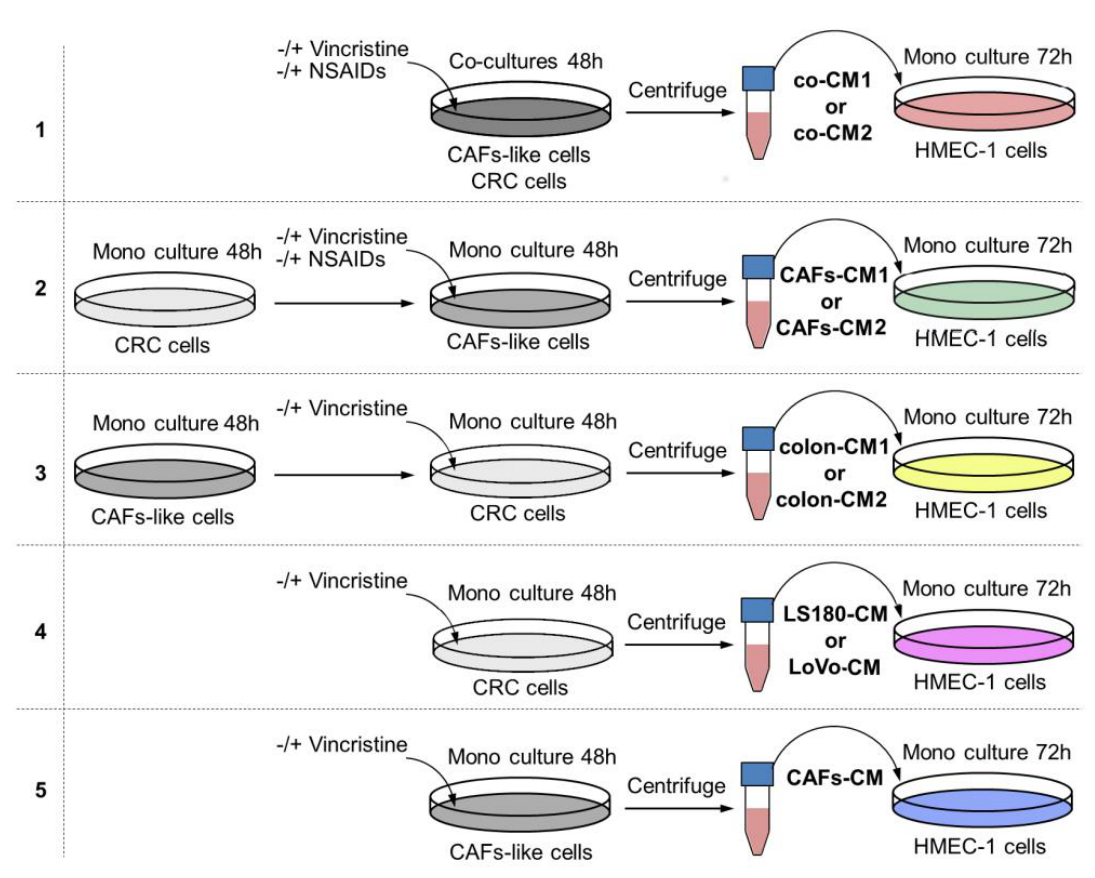
Figure 1. The research scheme for determining the role of NSAIDs in preventing vincristine-dependent CAF formation. In each experiment, the conditioned medium (CM) obtained from preinvasive colon cancer cells (LS180) was called CM1, and from invasive cell line LoVo, CM2. Each CM was labeled with other colors according to the scheme. Model 1 . The coculture of colon cancer cell lines and CAF-like cells were maintained during 48 h and, if necessary, treated with vincristine (VIN) during the final 24 h. The CM was collected, centrifuged, and added to HMEC-1 cells grown in MCDB-131 medium in a 1:3 ratio for 72 h. In some experiments, NSAIDs (AsA or IBU) were added to the coculture cells for the final 24 h. Model 2 . The colon cancer cell lines were maintained in DMEM medium for 48 h. Next, CM was collected, centrifuged, and added to CAF-like cells. CAFs were treated, if necessary, with vincristine (VIN) during the final 24 h. Then, CM was collected, centrifuged, and finally added to HMEC-1 cells grown in MCDB-131 medium in a 1:3 ratio for 72 h. In some experiments, NSAIDs (AsA or IBU) were added to the CAF-like cells for the last 24 h. Model 3 . The CAF-like cells were grown for 48 h. Next, CM was collected, centrifuged, and added to colon cancer cell lines. Colon cancer cells were treated, if necessary, with vincristine (VIN) during the final 24 h. Then, CM was collected, centrifuged, and added to HMEC-1 cells grown in MCDB-131 medium in the 1:3 ratio for 72 h. Model 4 . The colon cancer cell lines were maintained in DMEM medium for 48 h. The CM was collected, centrifuged, and finally added to HMEC-1 cells grown in MCDB-131 medium in the 1:3 ratio for 72 h. In some experiments, vincristine was added to the colon cancer cells for the last 24 h. Model 5 . The CAF-like cells were maintained in DMEM medium for 48 h. Then, CM was collected, centrifuged, and finally added to HMEC-1 cells grown in MCDB-131 medium in the 1:3 ratio for 72 h. In some experiments, vincristine was added to the CAF-like cells for the final 24